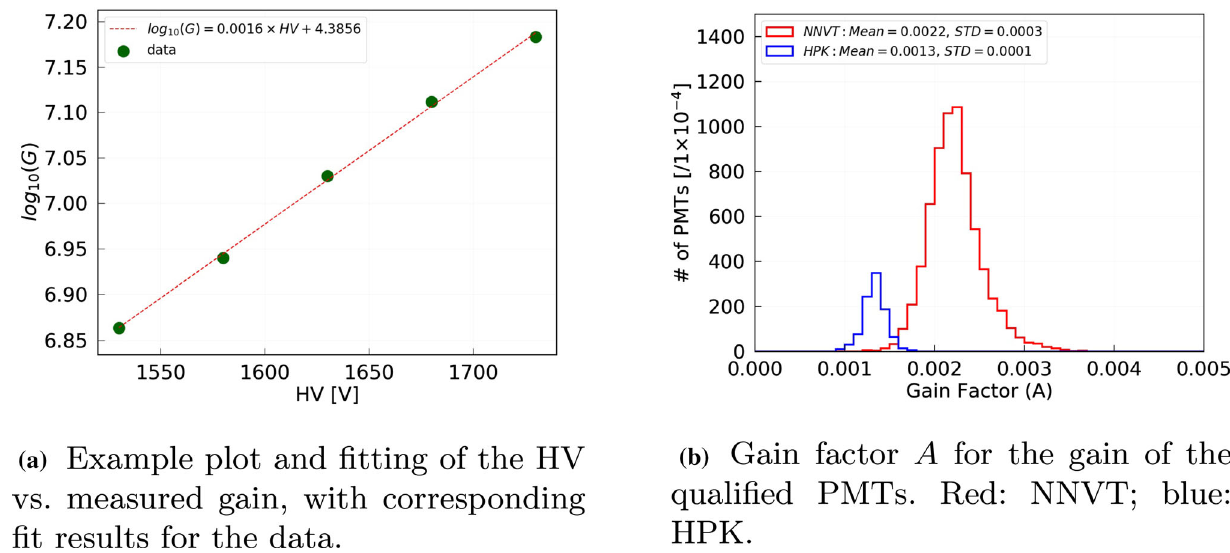
Fig. 11 Example plot for a HV vs. gain fit (left, for a single PMT) and the distribution of the fitted gain factor A (as introduced in Eq. 3) of all qualified PMTs